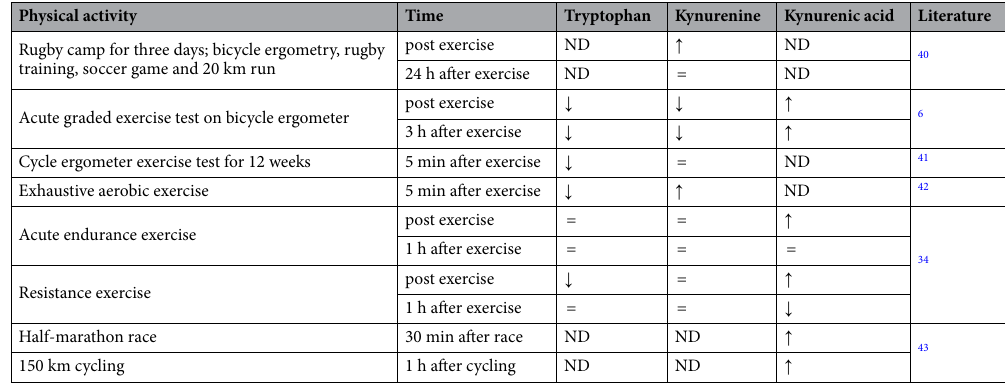
Table 2. Effects of physical activities on tryptophan, kynurenine and kynurenic acid content in human blood: an overview. ↑ increase; ↓ decrease; = no change; ND—no data.